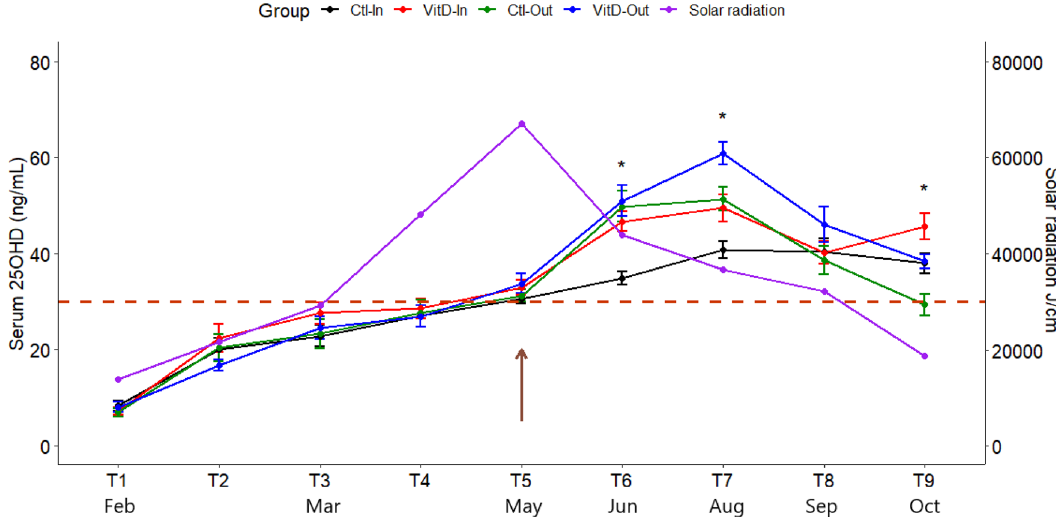
Figure 1. Vitamin D 3 supplementation and sunlight exposure increases 25OHD circulating levels in calves. Ctl-In (n = 11) and VitD-In (n = 12) groups were kept indoors and fed with 6000 IU/kg in MR + 2000 IU/kg of Vit D 3 in ration; or 10,000 IU/kg in MR + 4000 IU/kg of Vit D 3 in ration, respectively. Whereas Ctl-Out (n = 11) and VitD-Out (n = 10) groups were move outdoors after weaning and fed with 6000 IU/kg in MR + 2000 IU/ kg of Vit D 3 in ration; or 10,000 IU/kg in MR + 4000 IU/kg of Vit D 3 in ration, respectively. All calves received a single time injection of 50,000 IU of Vit D 3 at T1, except Ctl-In, which received a vehicle injection with ethanol. Serum samples were taken at the beginning of the trial (T1), after 15 days (T2) and at 30, 70, 90, 130, 160, 200 and 230 days after T1 (T3-T9). Data represent mean and standard error of serum 25OHD profile in calves for each time point within each group. The main effect of sunlight and treatment was significant ( p < 0.05) at T6, T7 and T9. Red dotted line shows the recommended 25OHD serum level of 30 ng/ml. Brown arrow shows the time where Ctl-Out and VitD-Out groups were moved outside. Right Y-axis represent the solar radiation during the time points where 25OHD concentrations were analysed.